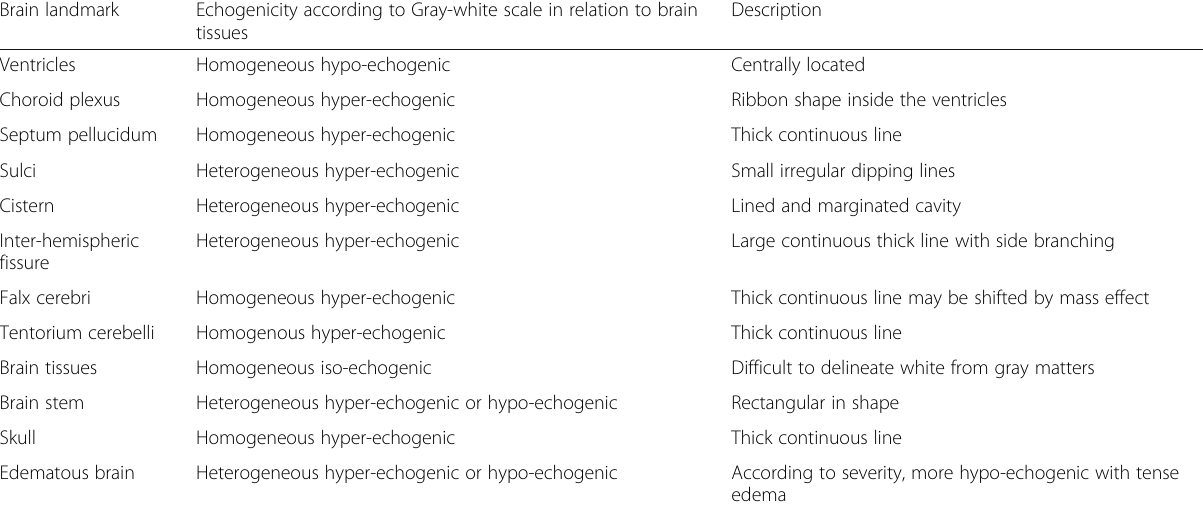
Table 2 Brain landmarks by intraoperative ultrasound Brain landmark